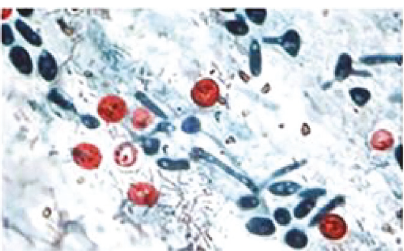
Figure 1: Bacteria in swimming pools.